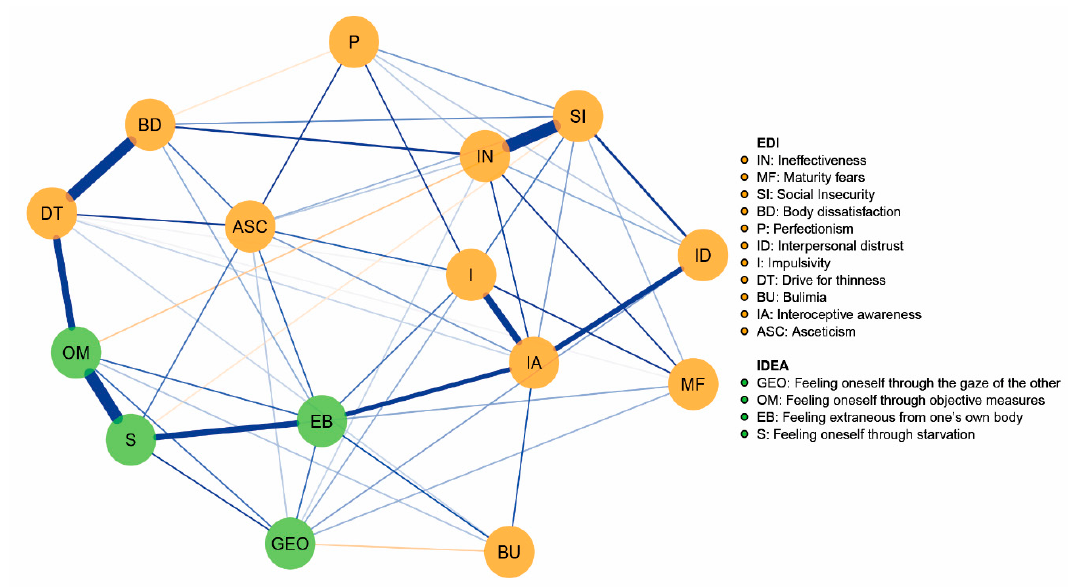
Figure 1. Estimated network of the sample population.